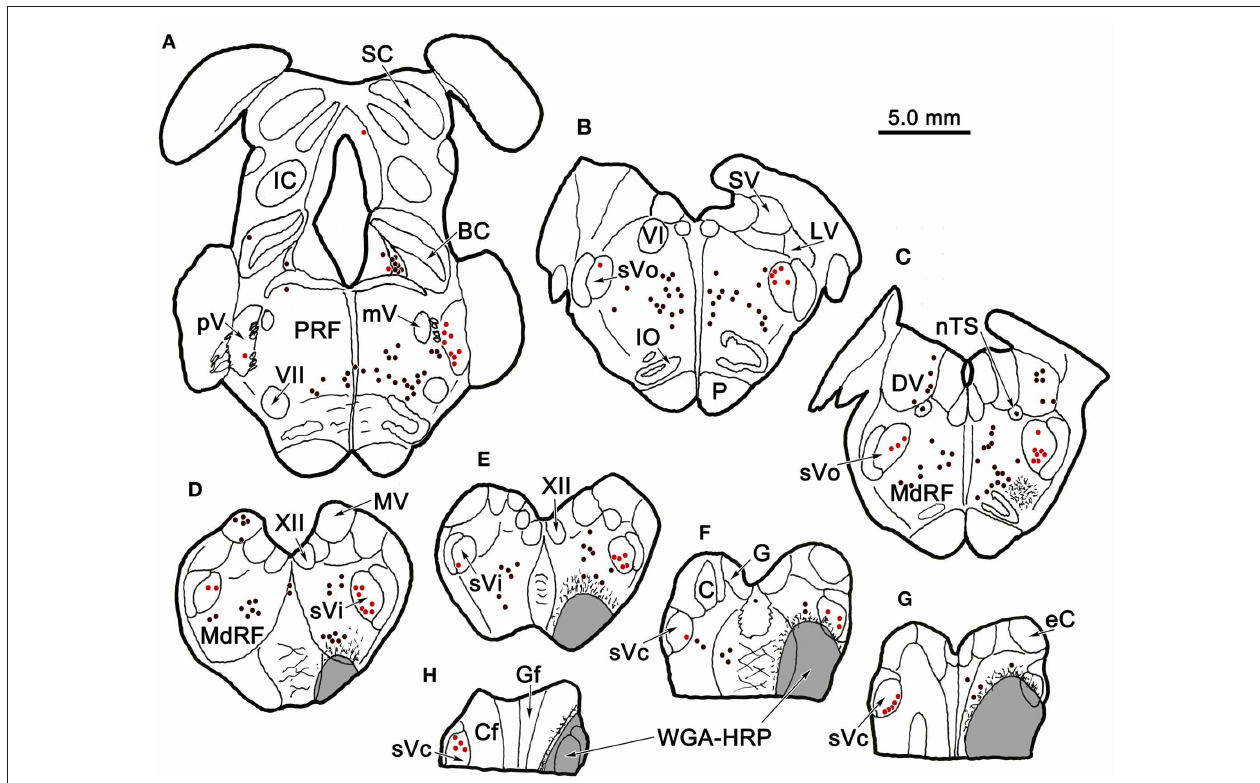
FIGURE 6 | Distribution of retrogradely labeled neurons in the trigeminal nuclear complex (red dots) and the brainstem (black dots) following an injection of WGA-HRP into sVc (F–H) and the adjacent reticular